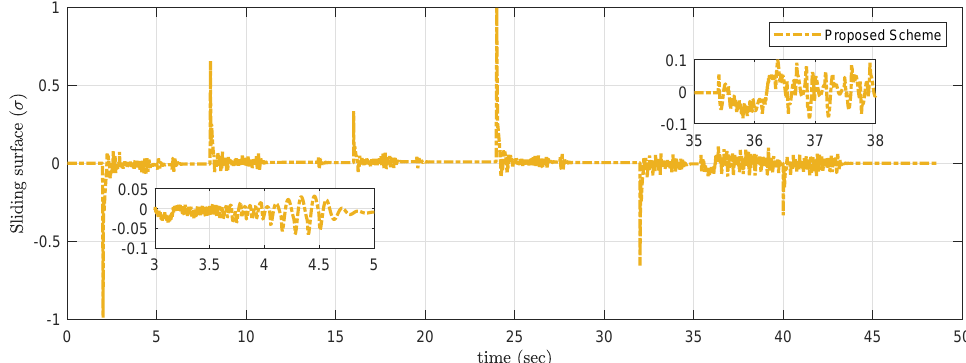
Figure 18. Experimental result of sliding surface σ